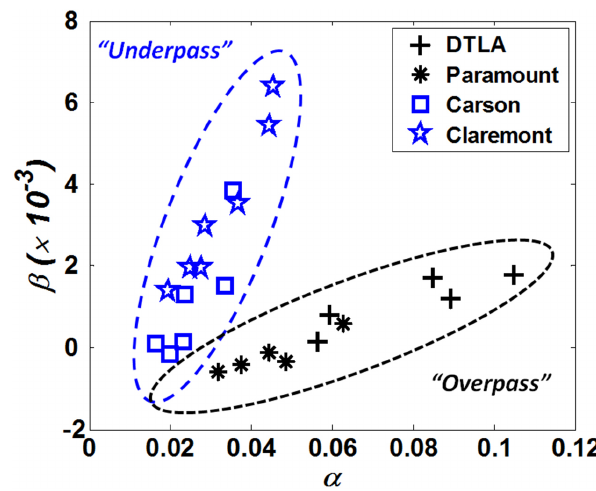
Figure 3. Relationship between α and β obtained from the fits of the semi-empirical GB model to the daily mean spatial profiles of UFP in the DTLA (black crosses), Paramount (black asterisks), Carson (blue squares), and Claremont (blue stars) transects. Black dotted line represents overpass freeway transects, where freeways over- pass the transects, and blue dashed line underpass freeway transects, where freeways pass under the